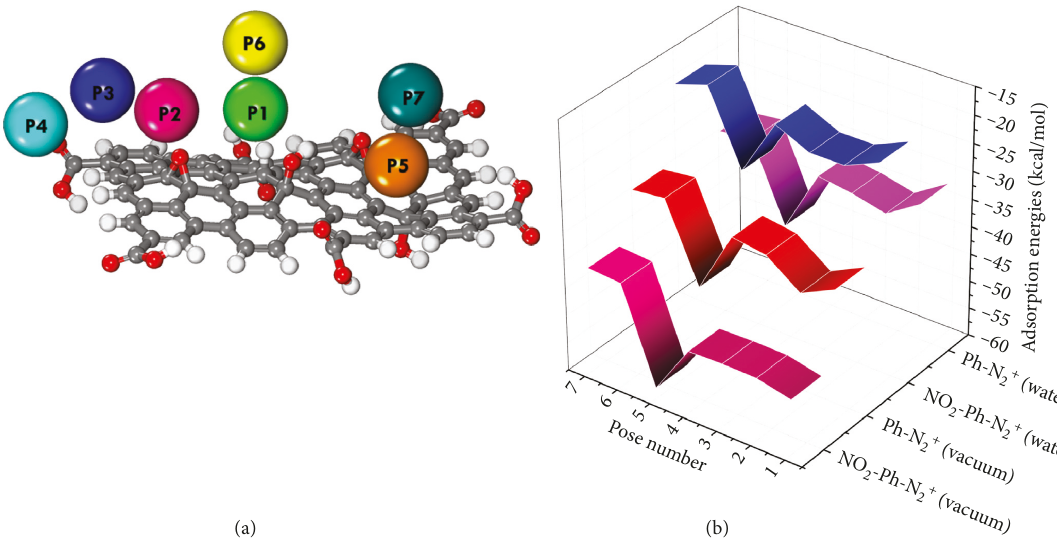
Figure 1: (a) Adsorption site positions for diazonium structures (P1–P5: flat lying onto the GOx surface; P6 and P7: perpendicular to the diazonium group oriented towards the GOx surface) and (b) the computed adsorption energies (in vacuum and water) of aryldiazonium cations onto the different GOx adsorption